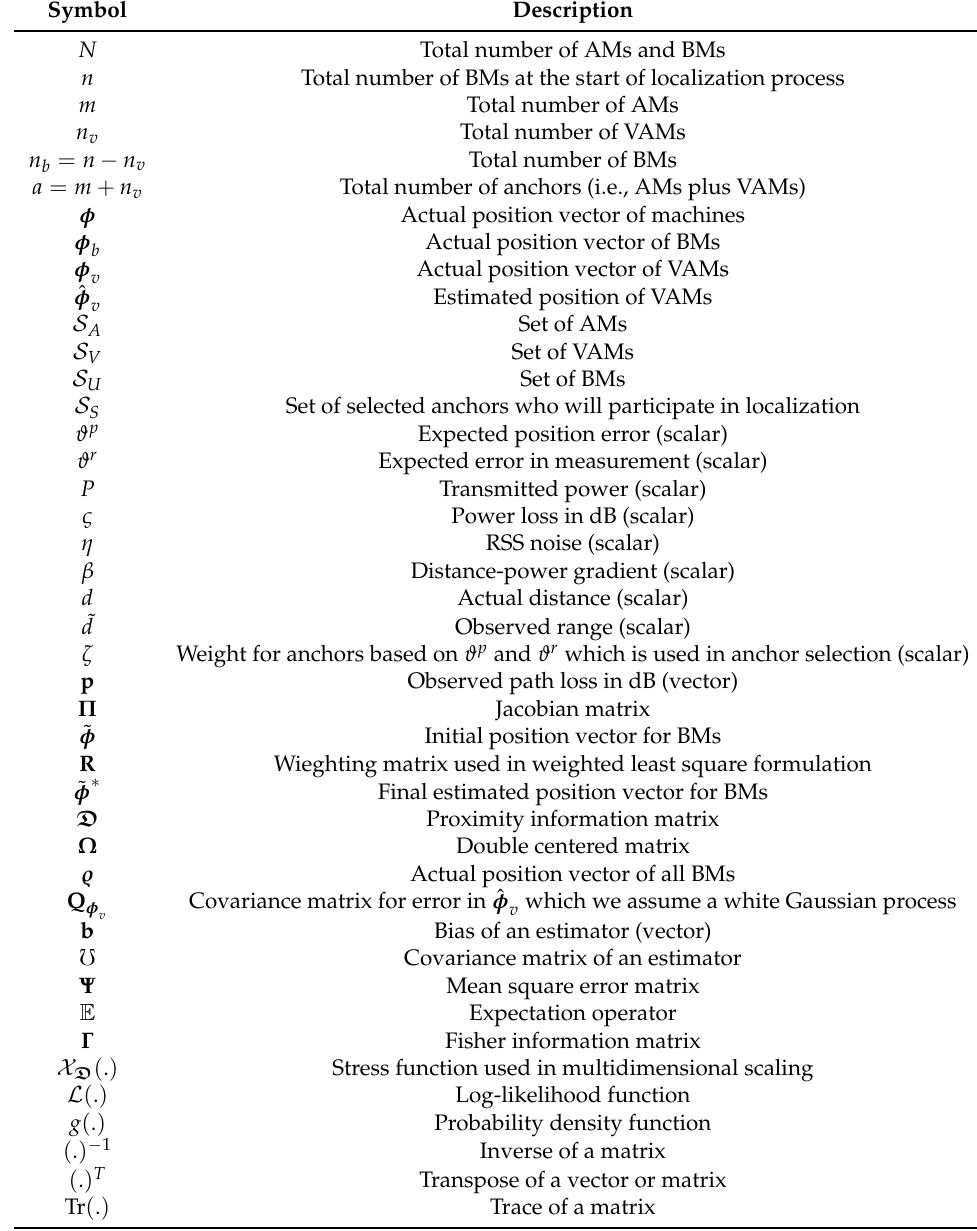
Table 1. Symbols and notations. AMs: anchor machines; BMs: blind machines; VAMs: virtual anchor